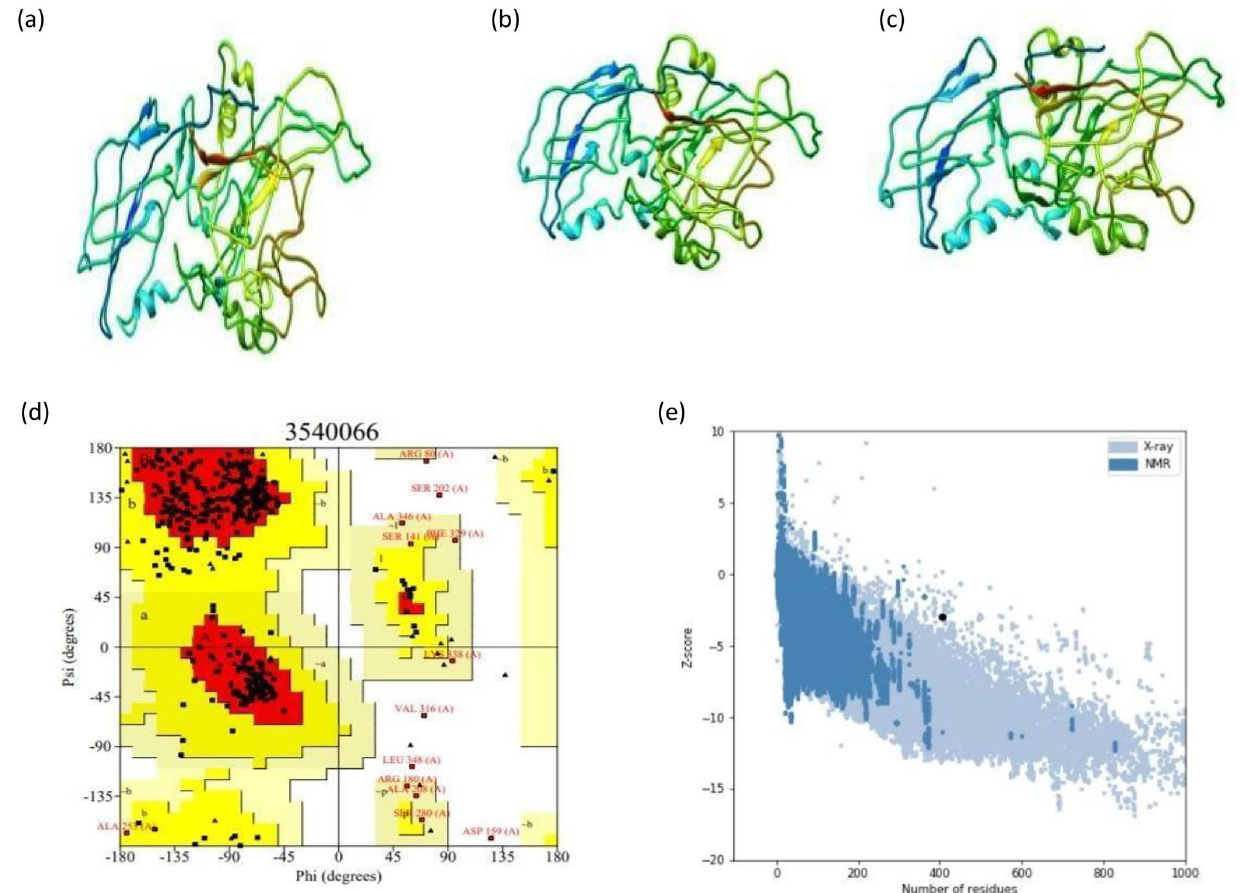
Figure 8. Modeling, refinement and validation of tertiary structures. ( a ) Multi-epitope vaccine chimeric protein 3D model generated using homology modelling (Chimera 1.15—https:// www. cgl. ucsf. edu/ chime ra/ downl oad. html). ( b ) Refined model using 3Drefine (Chimera 1.15—https:// www. cgl. ucsf. edu/ chime ra/ downl oad. html). ( c ) GalaxyRefine generated refined 3D structure (Chimera 1.15—https:// www. cgl. ucsf. edu/ chime ra/ downl oad. html). ( d ) Ramachandran plot of vaccine construct V1. ( e ) Prosa-Web giving a Z- score of -2.9.